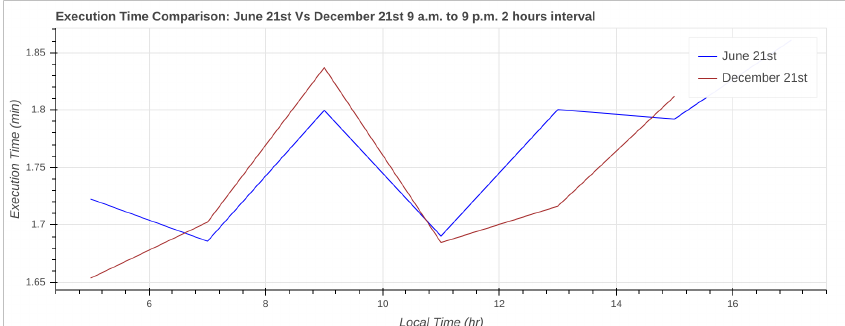
Figure 14. Execution time required for